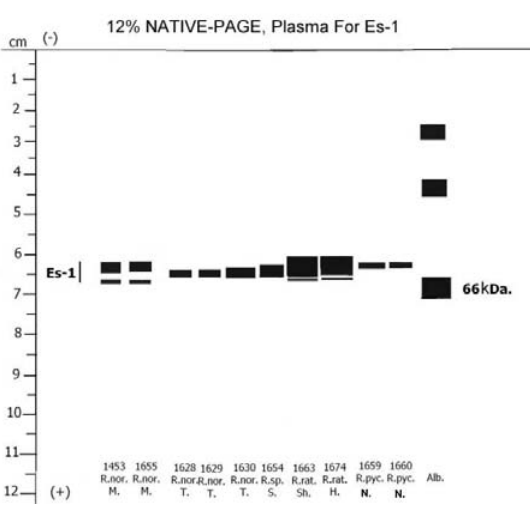
F IGURE 3. Zymogram of the gel electrophoresis for esterase-1 of plasma using NADA as a substrate. R. norvegicus from Mashhad (FUMZM 1453, FUMZM 1655), R. norvegicus from Tehran (FUMZM 1628, FUMZM 1629, FUMZM 1630), Rattus sp. from Semnan (FUMZM 1654), R. rattus from Shiraz (FUMZM 1663), R. rattus from mangrove forests (FUMZM 1674), R. pyctoris from Noghodar (FUMZM 1659, FUMZM 1660), and Albumin marker. ♂ : male, ♀ :